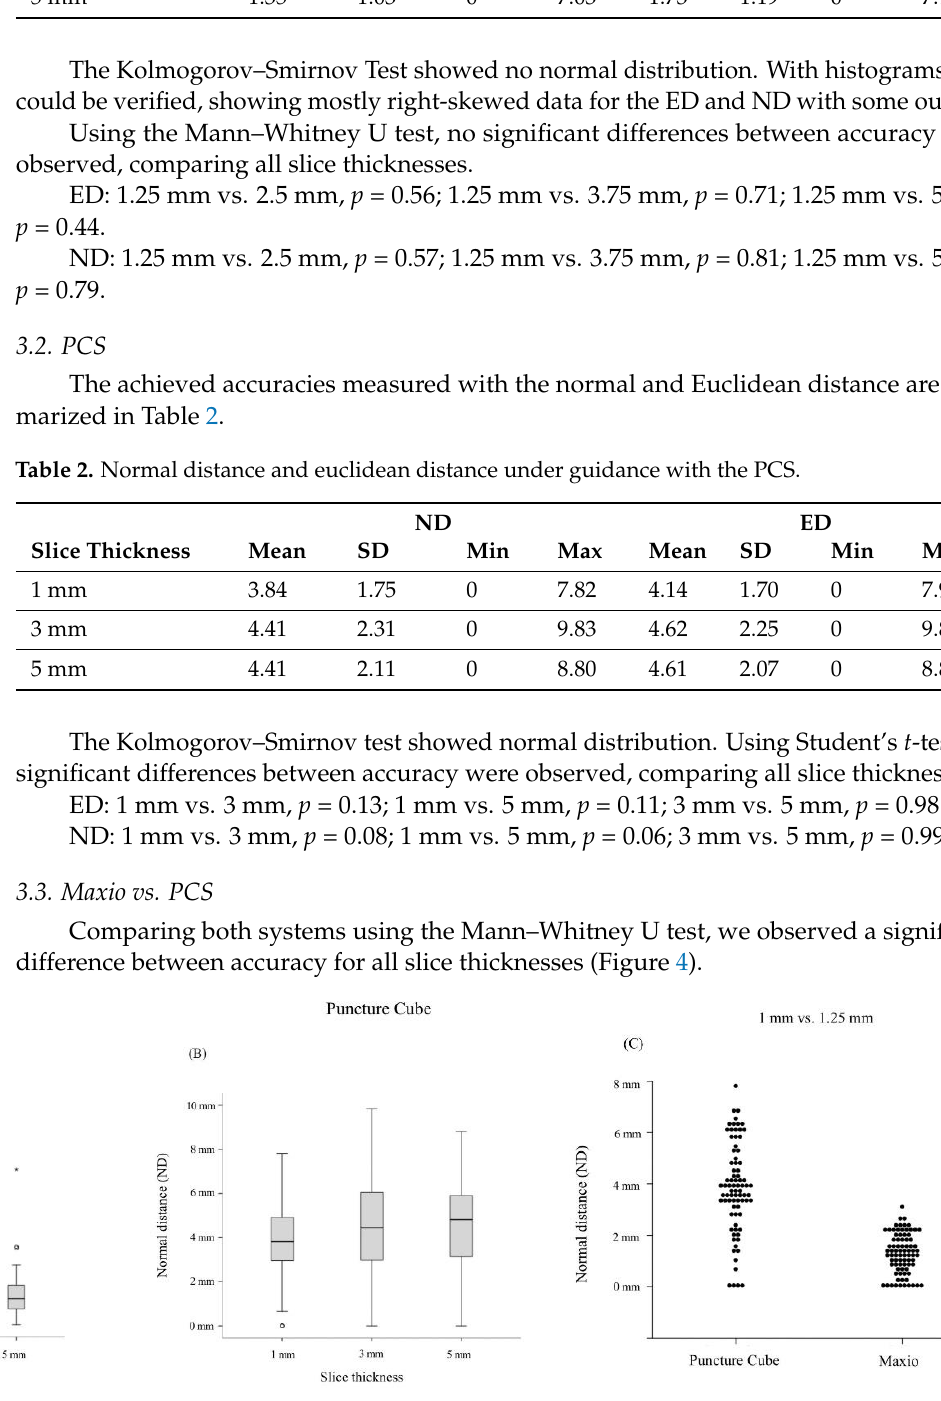
Figure 4. ( A , B ) Boxplot of the PCS vs. Maxio comparing the accuracy between all slice thicknesses. ( C ) Dot-plot of the PCS vs. Maxio comparing accuracy for the finest slice thickness. ED (Maxio vs. PCS): 1.25 mm vs. 1 mm, p < 0.001; 2.5 mm vs. 3 mm, p < 0.001; 3.75